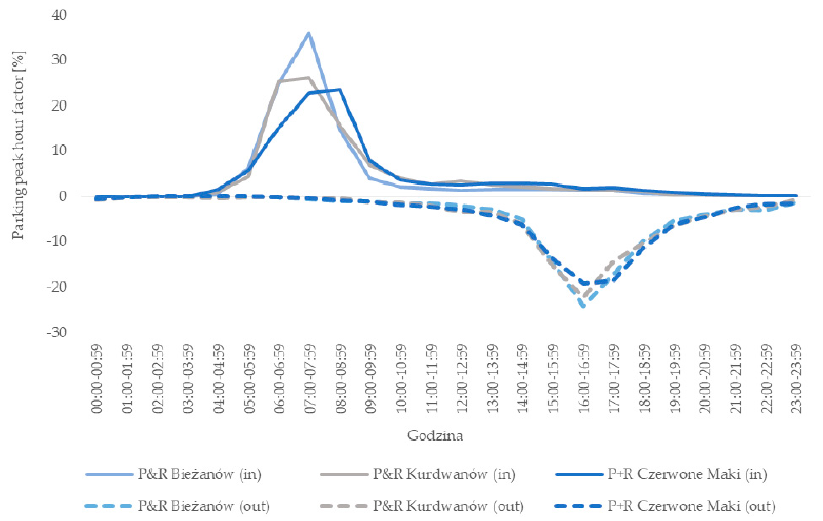
Figure 12. Parking peak ‐ hour factor for P&R parking in Cracow.